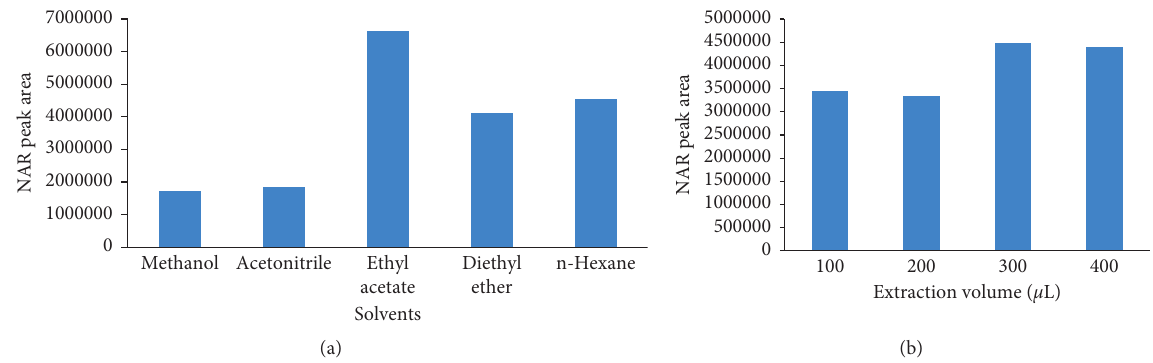
Figure 5: Effects of solvents on NAR extraction: (a) solvent selection and (b) ethyl acetate